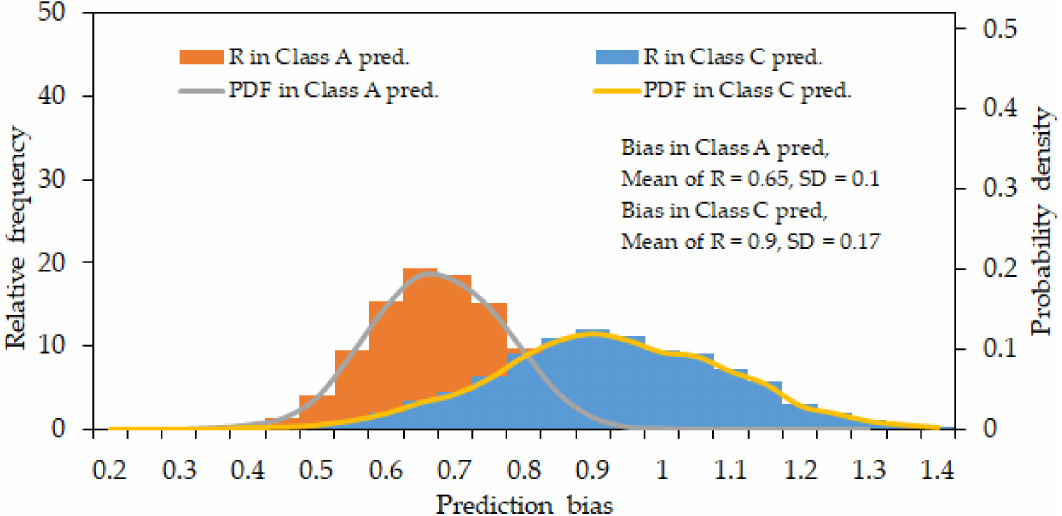
Figure 8. Distribution of settlement prediction bias for average values of R from Class A and Class C pred.—Karakore clay.